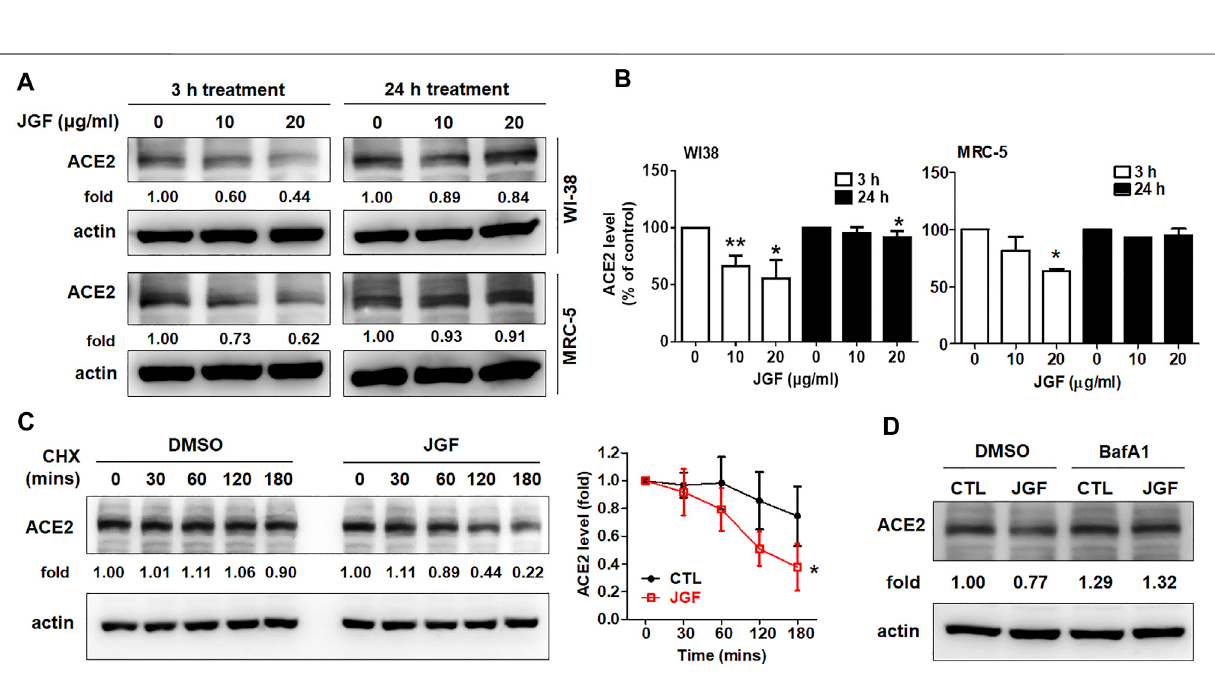
FIGURE 2 | The effect of JGF on the cell viability of lung fi broblast WI-38 and MR/C-5 cells. WI-38 (A) and MRC-5 (B) cells were treated with various low concentrationsofJGF(0 – 20 μ g/ml)for48and72 h.EachgroupofJGF-treatedsampleswasnormalizedagainstanuntreatedcontrol.Cellviabilitywasdeterminedusing a crystal violet assay. Data were representative of three separated experiments and were presented as the mean ± SD; error bars indicated SDs.